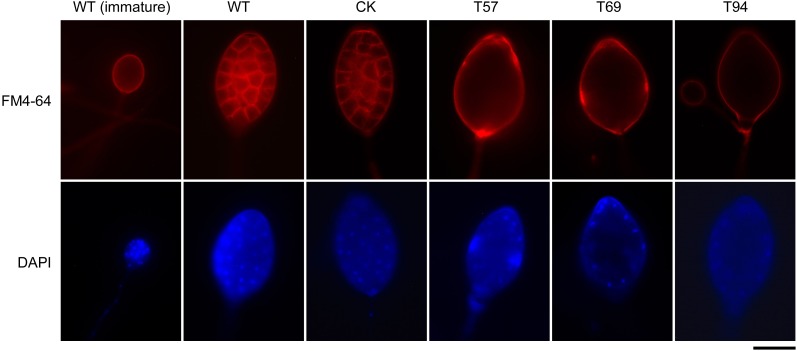
Nuclei distribution and cytoplasm cleavage within sporangia are hindered in PsMAD1 mutants. The nuclei in sporangia were detected with DAPI staining. Plasma membrane was observed by FM4-64 staining. Scale bar = 20 μm.